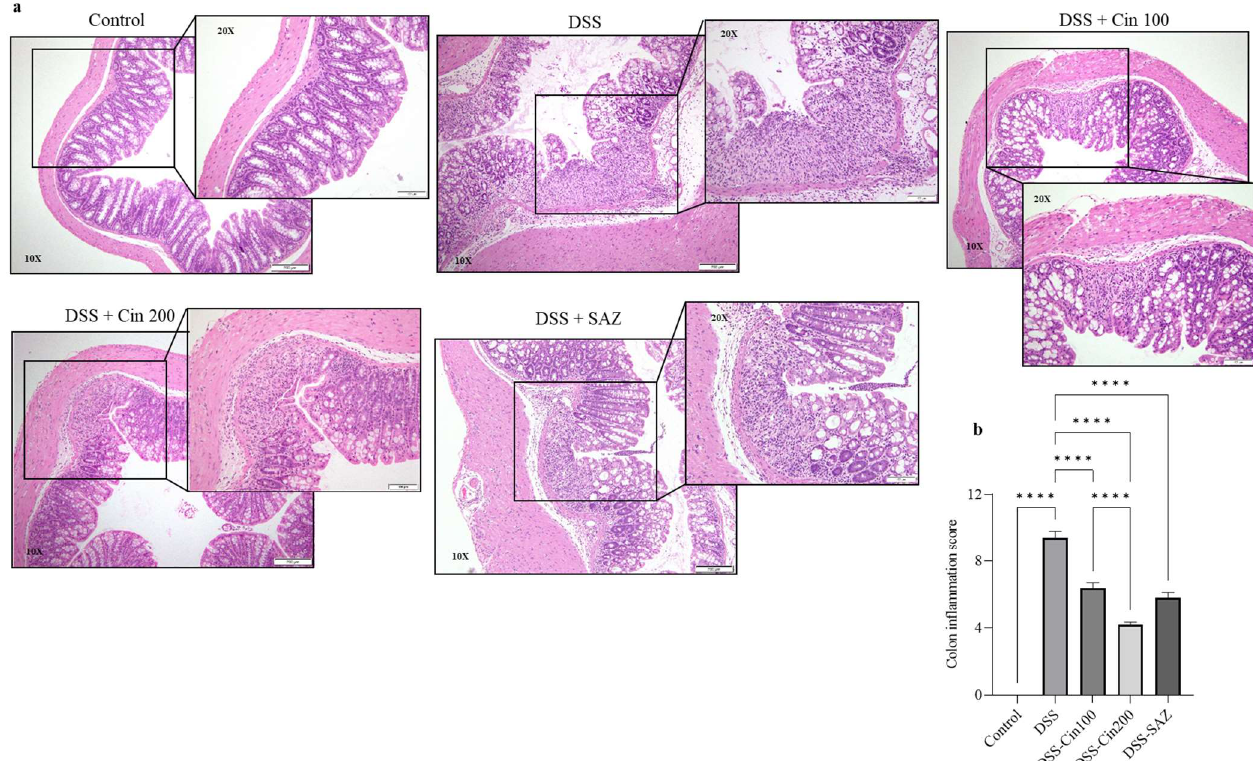
Figure 3. Effect of 1,8-cineole on colon histology. ( a , b ) DSS administration significantly increased the colonic inflammation score and crypt aberration. 1,8-cineole treatment significantly prevented the increase in the colonic inflammation score and protected against crypt aberration. Data were obtained from n = 6 animals per group. The results are expressed as the means ± SEM. **** p ≤ 0.0001.